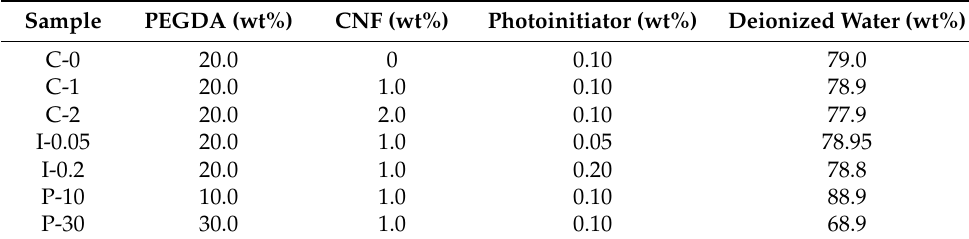
Table 2. Formulas of cellulose nanofiber (CNF)/polyethylene glycol diacrylate (PEGDA) photocur- able resin